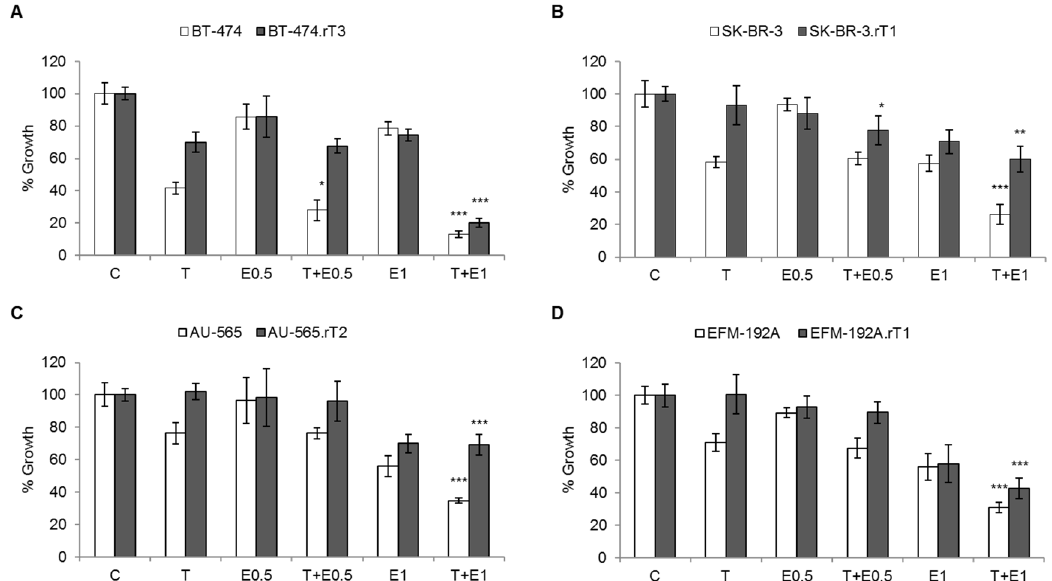
Figure 4. Effect of blocking mTOR activation by everolimus on trastuzumab sensitivity in trastuzumab-sensitive and trastuzumab-acquired resistance cell lines. Sensitive and trastuzumab-resistant cells were treated for seven days with DMSO, 15 µg/mL trastuzumab (T), 0.5 or 1 nM everolimus (E), or a combination of 15 µg/mL trastuzumab plus 0.5 or 1 nM everolimus. Viable cells were then counted by trypan blue exclusion. Viability is presented as a percentage of the DMSO-treated control vector group. Error bars represent standard deviation between replicates ( n ≥ 2). * denotes p ≤ 0.05, ** denotes p ≤ 0.01 and *** denotes p ≤ 0.001. ( A ) BT-474 sensitive (BT474) and trastuzumab-resistant (BT-474.rT3) cells. ( B ) SK-BR-3 sensitive (SK-BR3) and trastuzumab-resistant (SK-BR-3.rT1) cells. ( C ) AU-565 sensitive (AU-565) and trastuzumab-resistant (AU-565.rT2) cells. ( D ) EFM-192A sensitive (EFM192A) and trastuzumab-resistant (EFM-192A.rT1) cells.